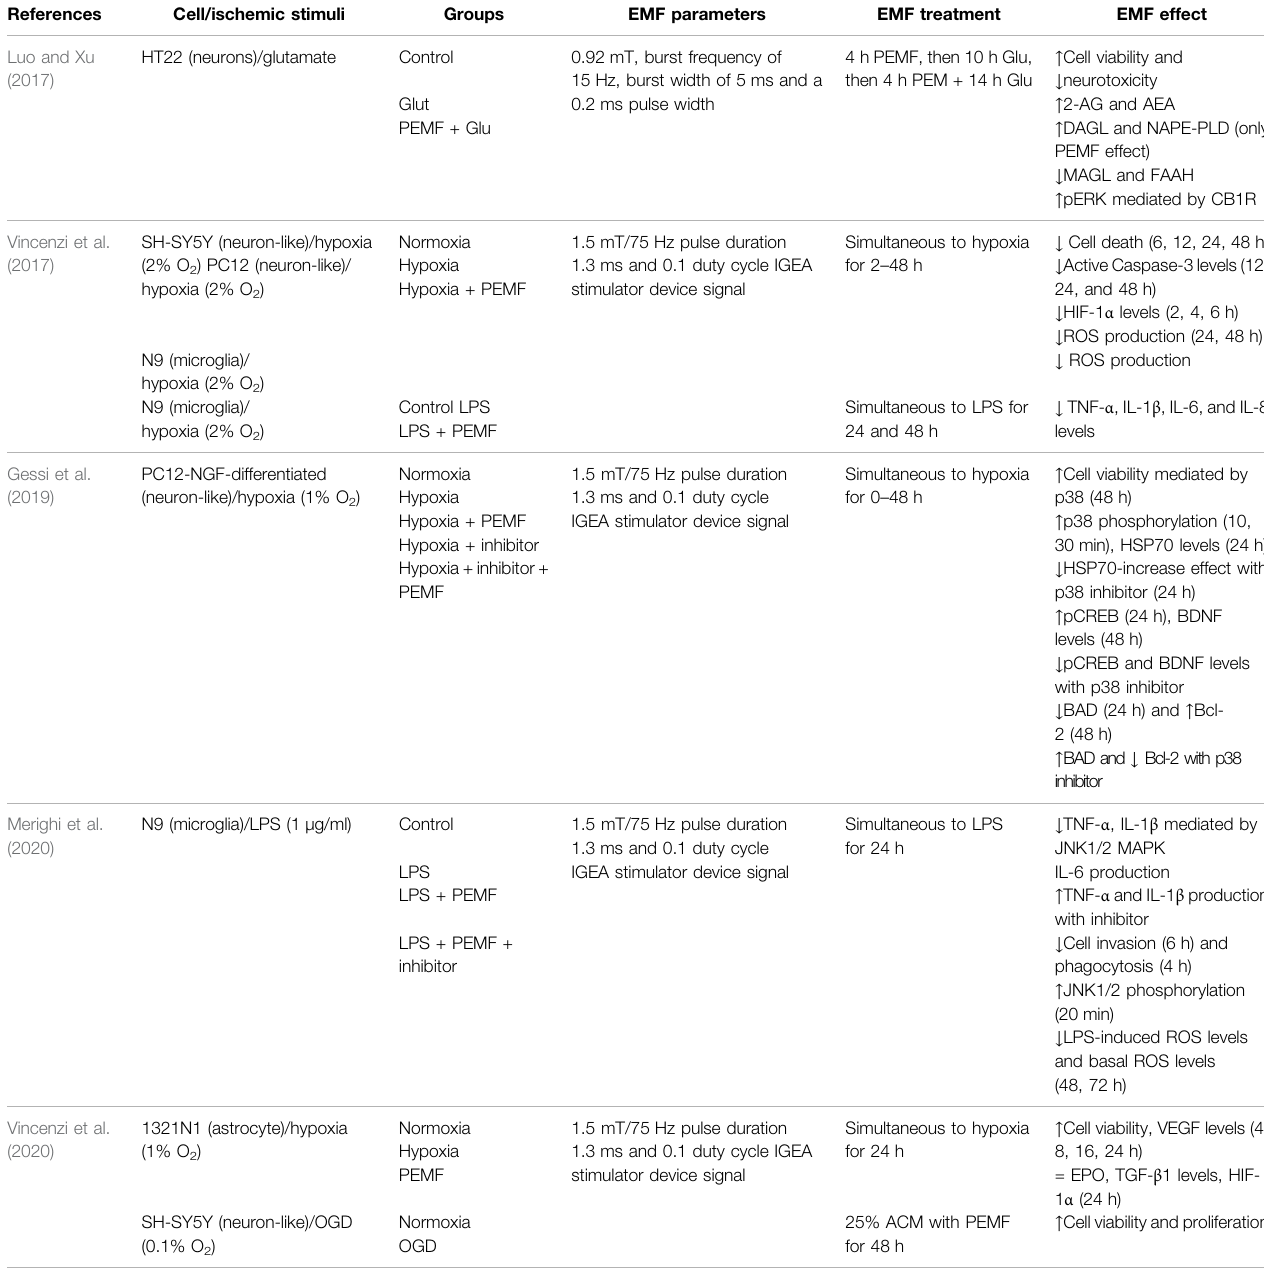
TABLE 3 | Overview of in vitro studies using pulsed electromagnetic fi eld (PEMF) as a treatment for ischemic